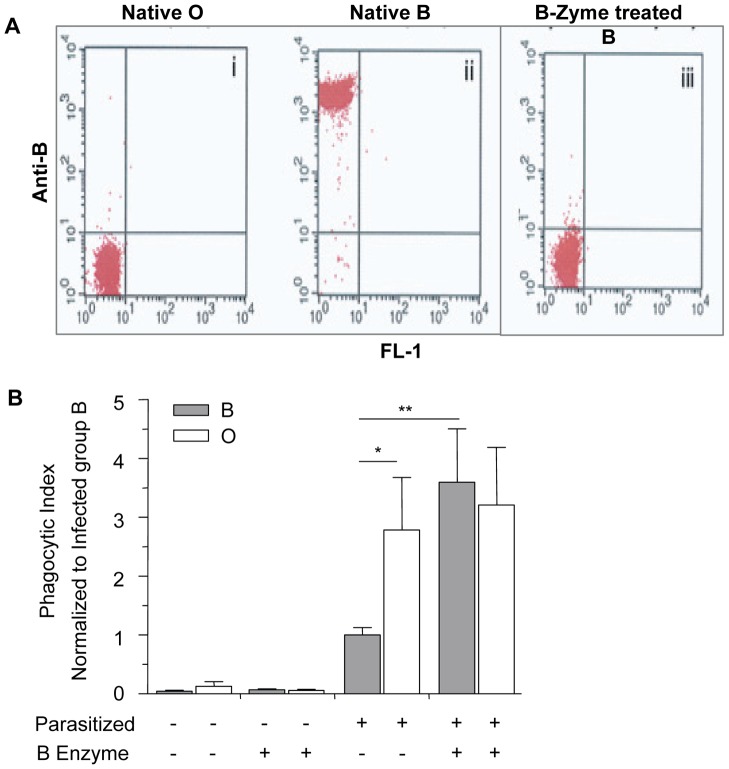
Blood group O (H antigen) status affects the phagocytic uptake of infected erythrocytes by human macrophages.Erythrocytes of blood group O and B were treated with B-zyme, thereby removing the terminal α-1,3-galactose from blood group B antigens. (A) Flow cytometric analysis with anti-B (clone 9621A8) and phycoerythrin (PE)-conjugated rat-anti-mouse kappa as secondary antibody. In the dot plot, the x and y axes represent FL1-derived fluorescence and PE-derived fluorescence, respectively, on logarithmic scales. Results show cleavage of the terminal galactose from B erythrocytes and enzymatic conversion from group B to erythrocytes which type as group O: (i) Native, untreated O erythrocytes, (ii) Native, untreated B erythrocytes, (iii) B-zyme-treated B erythrocytes. Group O cells mock-treated with B-zyme gave identical results to the group O untreated control (data not shown). (B) The phagocytic uptake was determined by counting the number of internalized infected erythrocytes in 250 individual macrophages and data was normalized to the average phagocytic index of infected untreated B erythrocytes. Data represent two independent experiments using the P. falciparum ITG clone. Each blood group is represented by four different donors. Bar graphs represent the mean±SEM. Significance was determined by Mann Whitney test with Bonferroni correction for multiple comparisons. There was an observed increase in the phagocytosis of untreated infected O erythrocytes when compared to untreated infected B erythrocytes (*p<0.05). The phagocytic index of the infected, B-zyme-treated B erythrocytes was significantly increased from phagocytic index of infected untreated B erythrocytes (**p<0.01). However, there was no significant difference in the uptake of treated vs. untreated infected O erythrocytes.